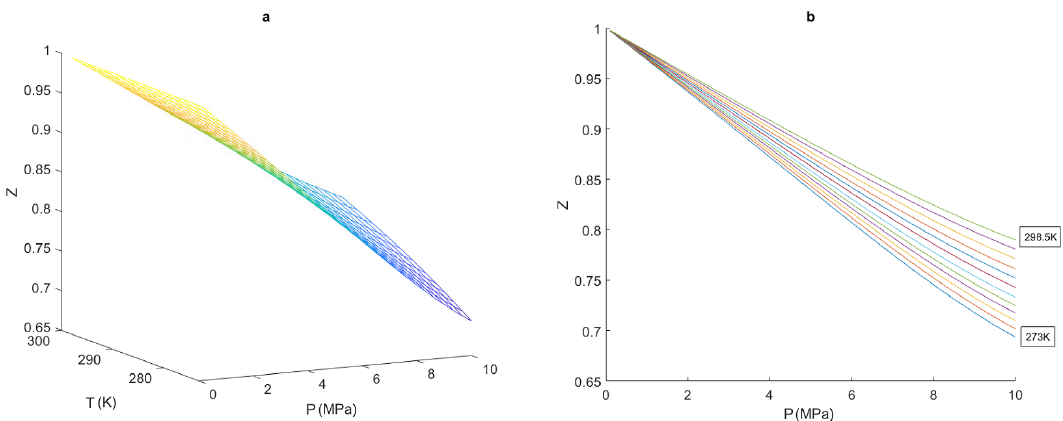
Figure 7. ( a ) Three-dimensional compressibility factor relationship with temperature–pressure; and ( b ) two-dimensional compressibility factor isothermal relationship with pressure for natural gas with a composition of: 85% methane, 14% ethane, and 1% nitrogen.